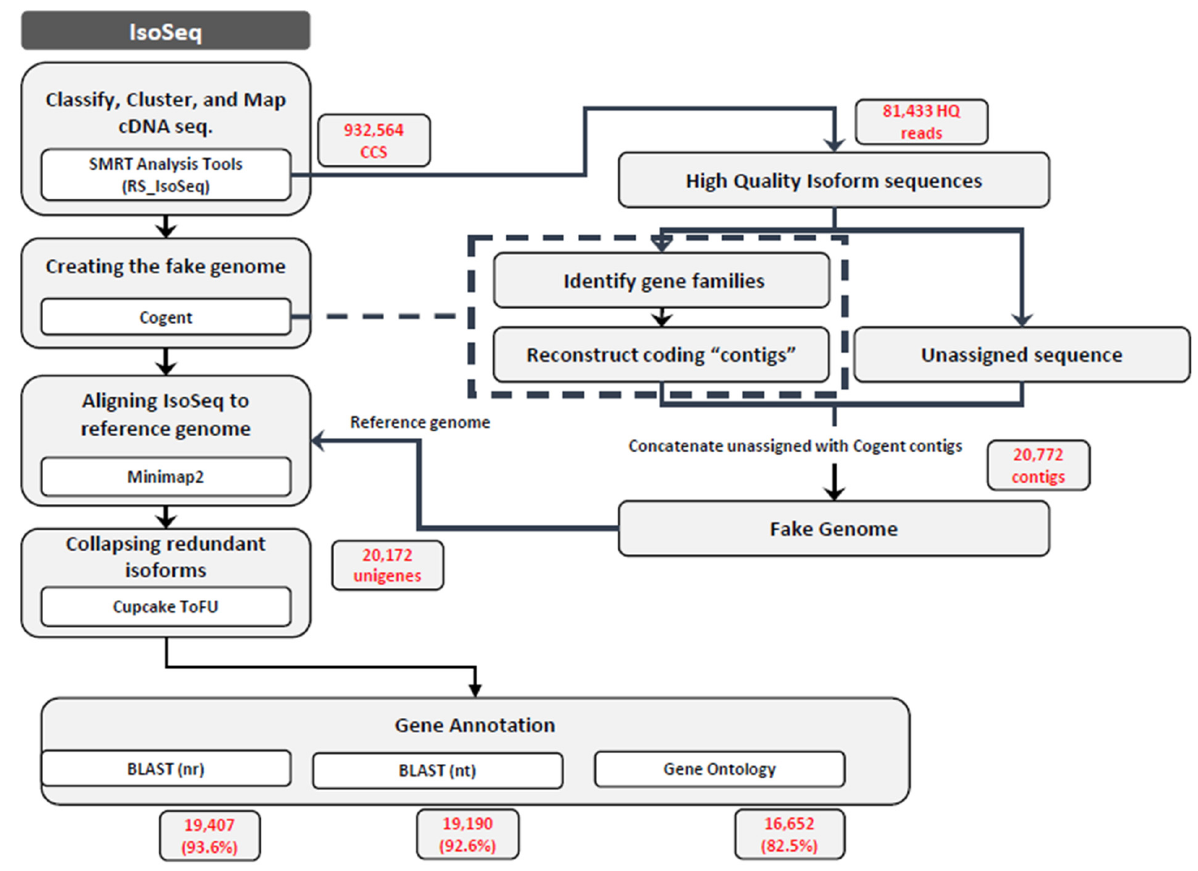
Figure 1. Schematic representation of full-length cDNA analysis in E. maculata.